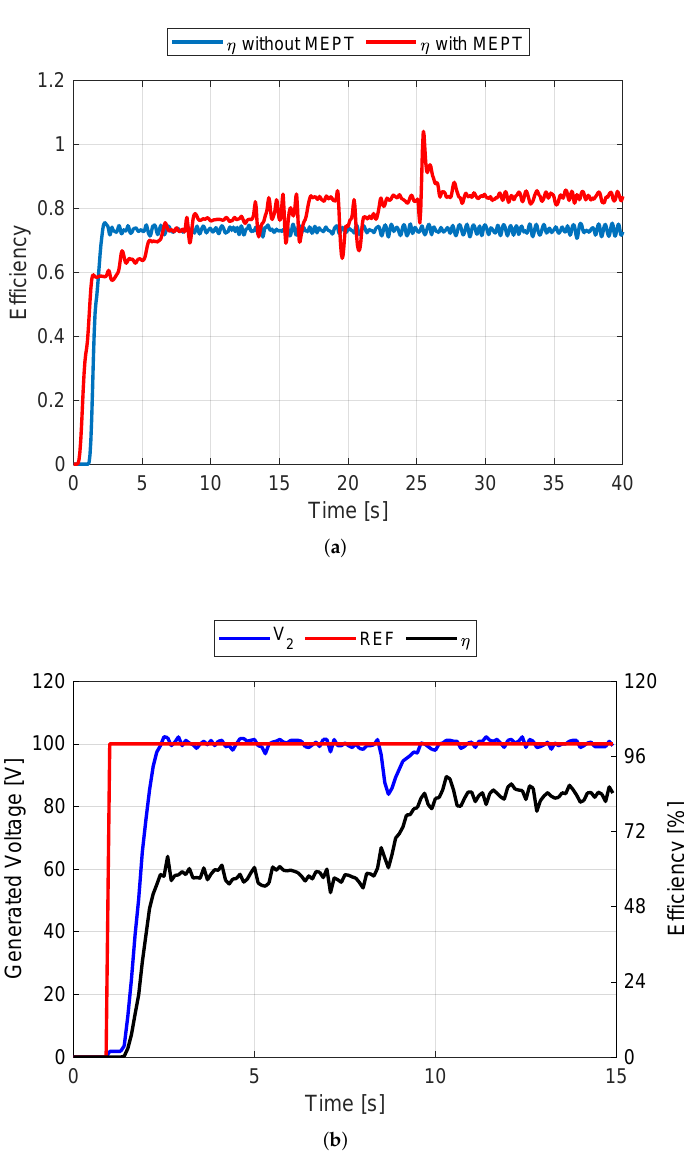
Figure 14. Simulation and experimental results for 100 V reference: ( a ) Simulation result: efficiency increase with MEPT algorithm; ( b ) Experimental result: controller performance and GRC